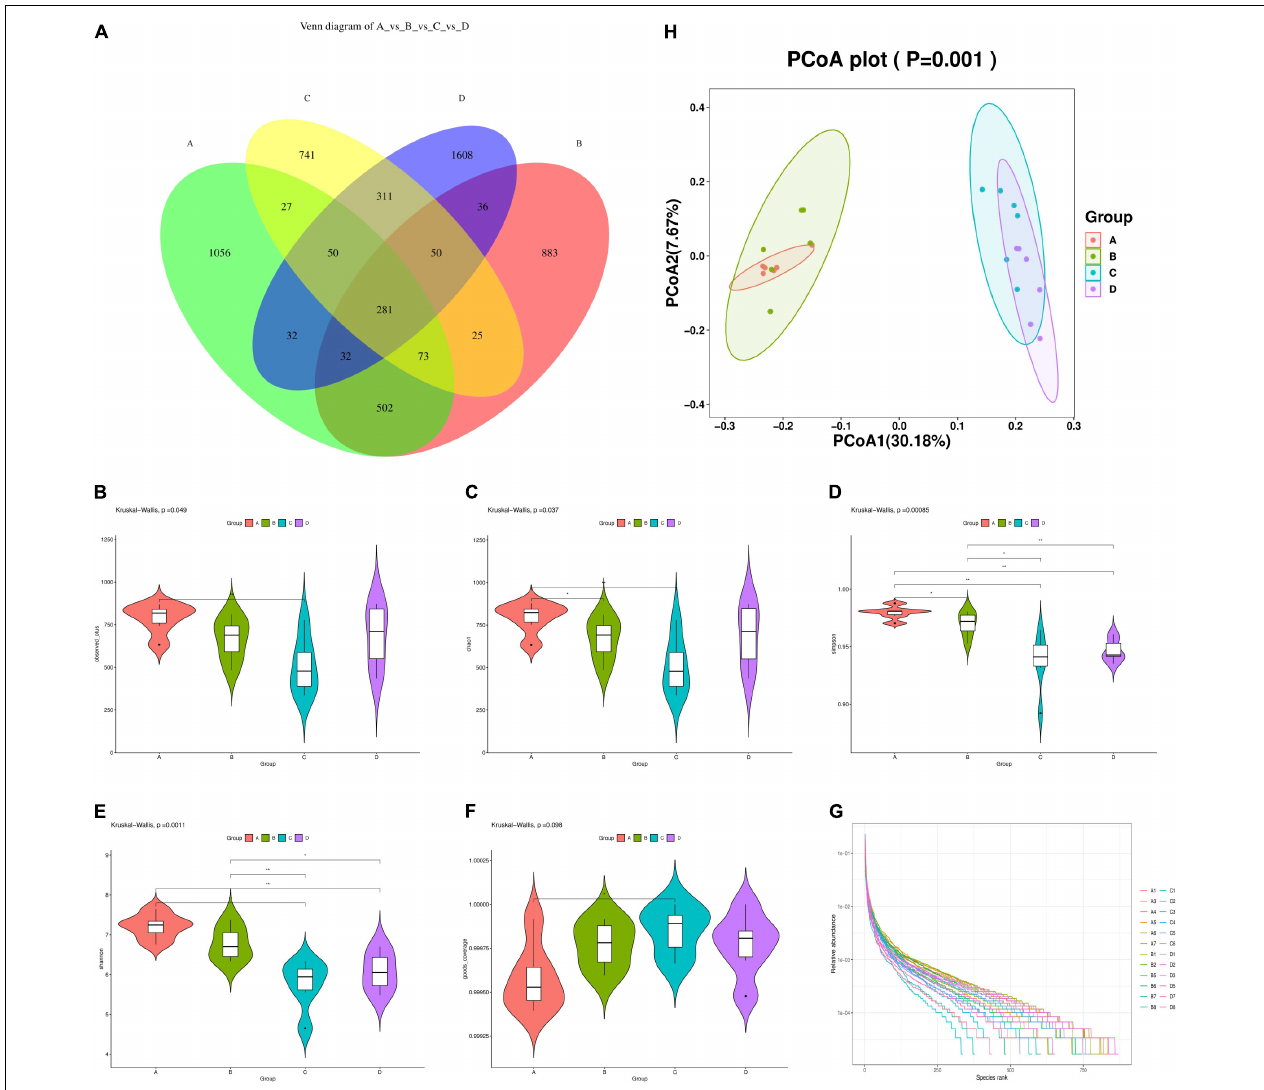
FIGURE 4 | Diversity analysis of intestinal microflora in mice ( n = 6). (A) Venn diagram (NCD vs. NCD + MBPs vs. HFD vs. HFD + MBPs). (B) Alpha diversity violin observed OTUs. (C) Alpha diversity violin Chao1. (D) Alpha diversity violin Simpson. (E) Alpha diversity violin Shannon. (F) Alpha diversity violin goods coverage. (G) Rank abundance graph. (H) Unweighted UniFrac PCoA. In the figure, A, B, C, and D represent NCD, NCD + MBPs, HFD, and HFD + MBPs,